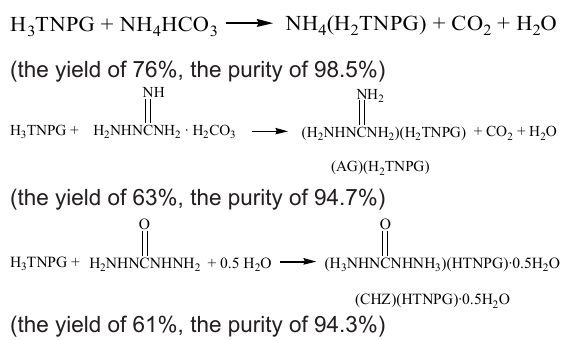
Figure 2. Chemical structures of AG (b), CHZ (c), and ATZ